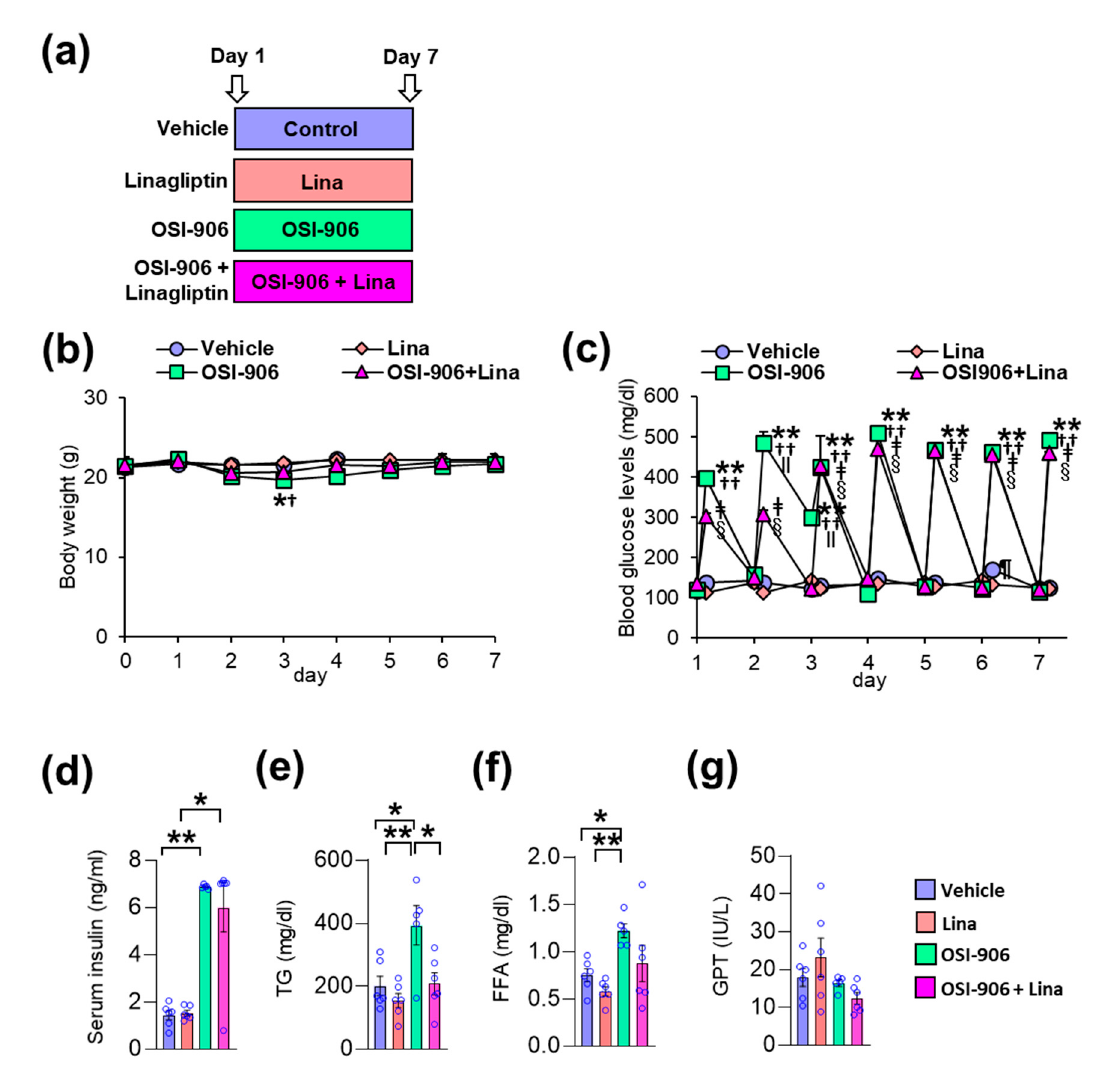
Figure 1. Linagliptin (Lina) improved OSI-906-induced hypertriglyceridemia in mice after 7 days of OSI-906 administration. ( a ) Experimental protocol ( n = 5–6). ( b ) Body weight during the experiment. Data represent the mean ± SEM. * p < 0.05, OSI-906 vs. vehicle; † p < 0.05, OSI-906 vs. Lina by